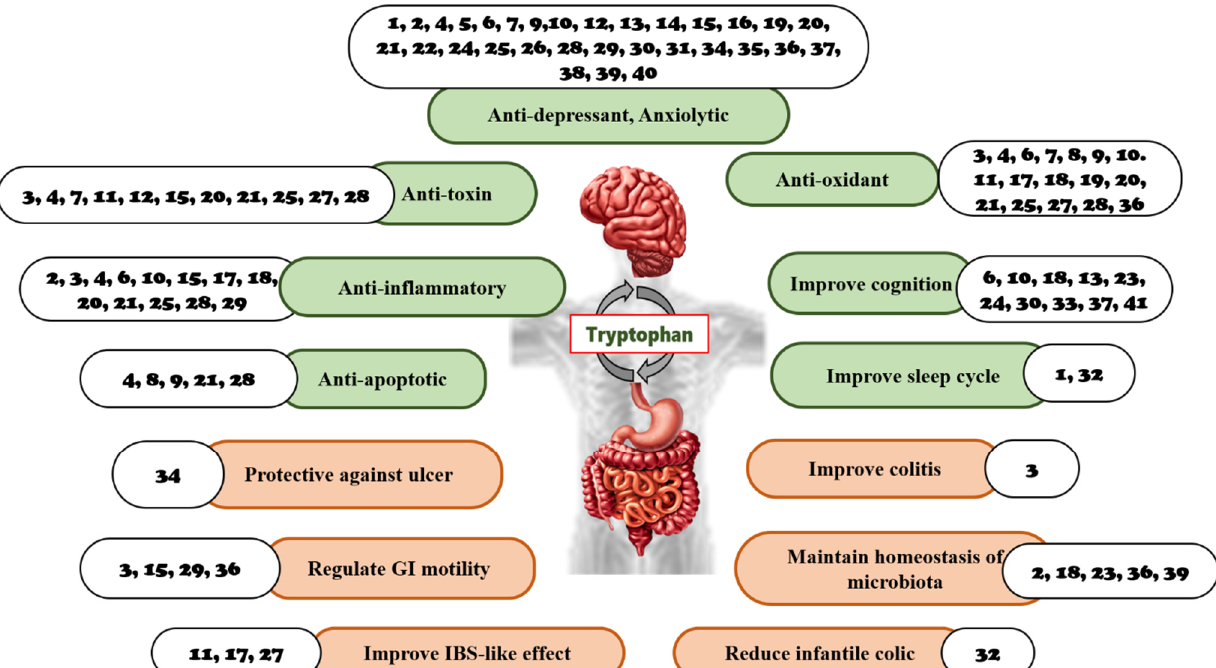
Figure 8. Natural products with neuroprotective and gastroprotective effects on the regulation of the GBA targeting tryptophan and its metabolites through different pathways: Specific natural products and the derived compounds exhibit specific functions in the bidirectional communication of the gut and brain. 1: anonaine, 2: anthocyanin, 3: asiaticoside, 4: astragaloside IV, 5: bacoside A, 6: